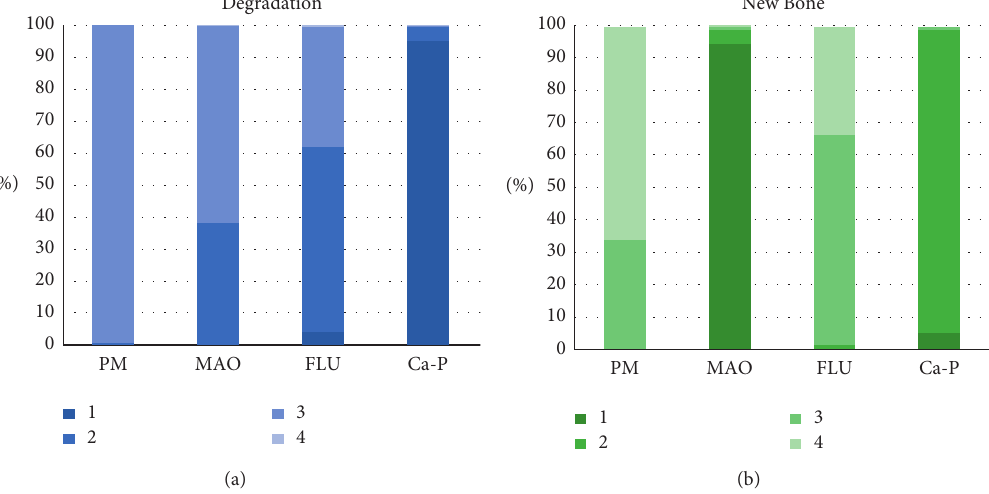
Figure 13: Ranking probabilities of different treatment under each outcome assessment: (a) % degradation and (b) new bone. Comprehensive Comparison